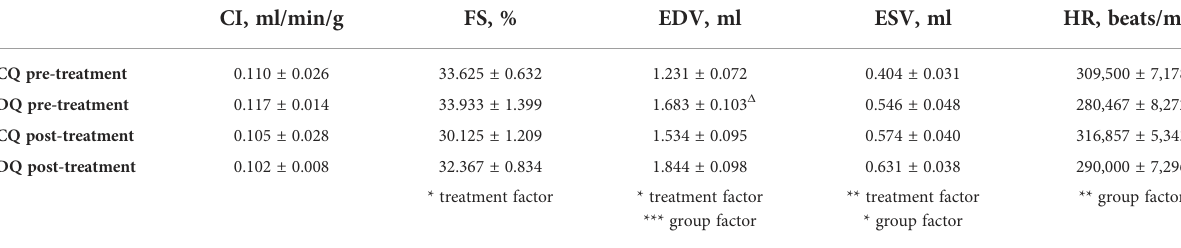
TABLE 1 Echocardiography data table of systolic and ventricular fi lling